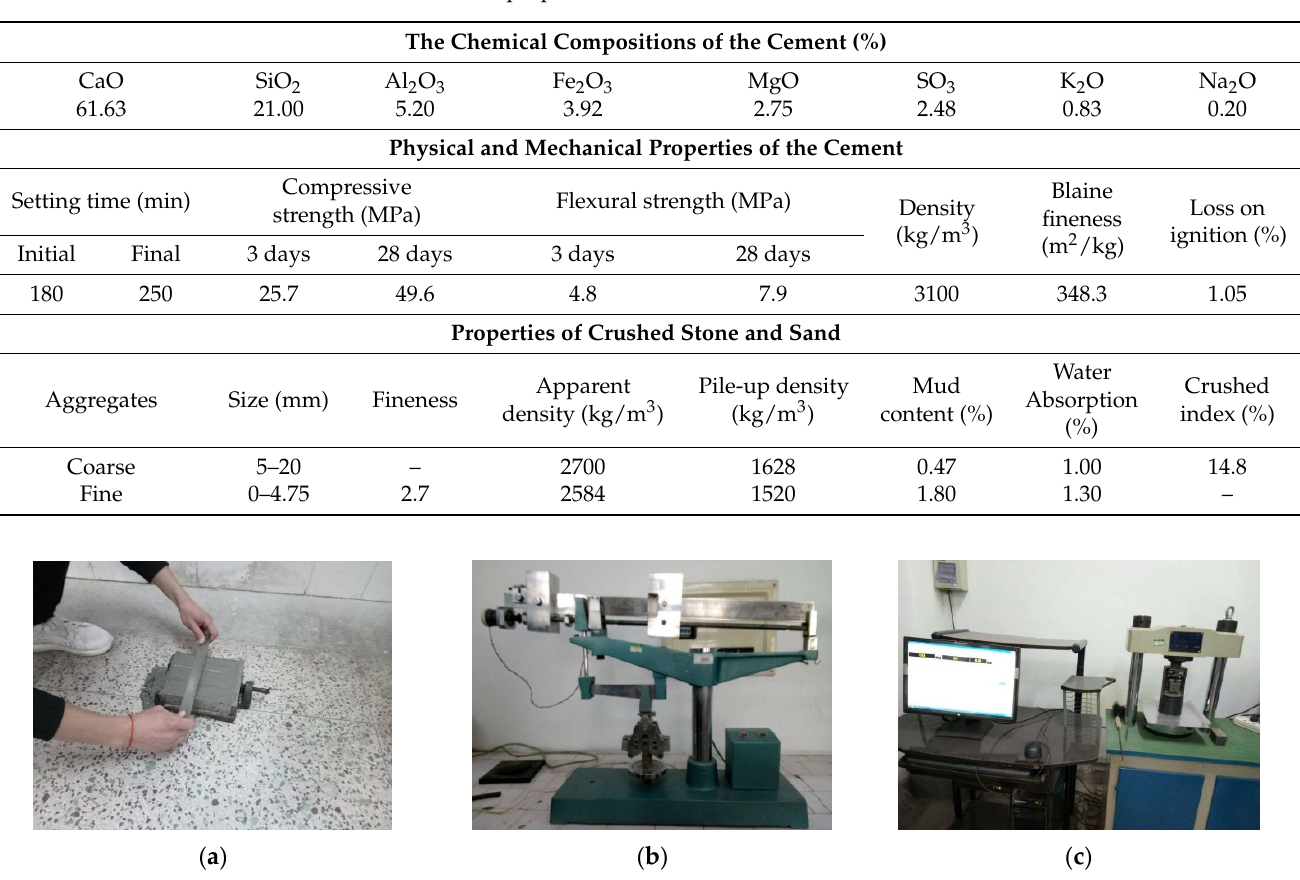
Figure 1. Preparation of cement mortar specimens and the test of their compressive and flexural strength: ( a ) Preparation of cement mortar specimens; ( b ) The test of cement mortar compressive strength; and ( c ) The test of cement mortar flexural strength.